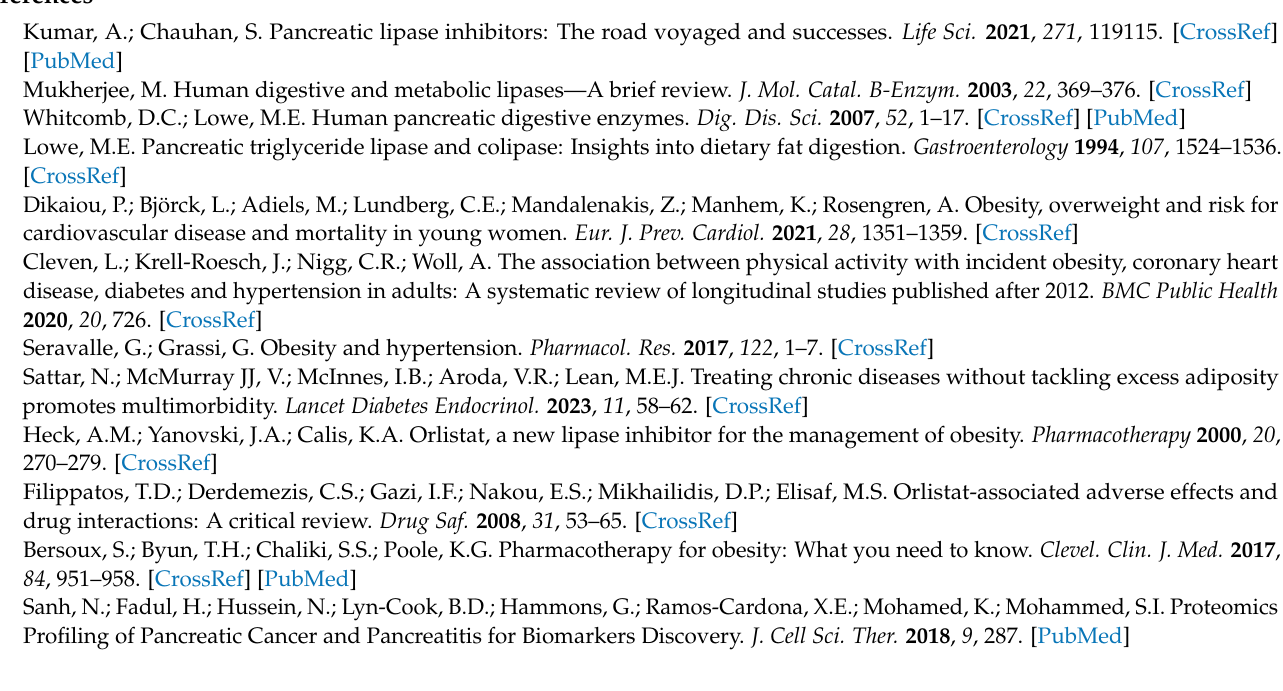
Figure S19: 1 H NMR spectra of compound Resorufin octanoyl ester; Figure S20: 13 C NMR spectra of compound Resorufin octanoyl ester; Figure S21: HRMS spectrum of compound Resorufin octanoyl ester; Figure S22: 1 H NMR spectra of compound Resorufin decanoyl ester; Figure S23: 13 C NMR spectra of compound Resorufin decanoyl ester; Figure S24: HRMS spectrum of compound Resorufin decanoyl ester; Figure S25: 1 H NMR spectra of compound RLE; Figure S26: 13 C NMR spectra of compound RLE; Figure S27: 1 H NMR spectra of compound Resorufin palmitoyl ester; Figure S28: 13 C NMR spectra of compound Resorufin palmitoyl ester; Figure S29: HRMS spectrum of compound Resorufin palmitoyl ester; Figure S30: 1 H NMR spectra of compound Resorufin stearyl esters; Figure S31: 13 C NMR spectra of compound Resorufin stearyl esters; Figure S32: HRMS spectrum of compound Resorufin stearyl esters; Table S1: The reported fluorescent substrates for sensing pancreatic lipase; Table S2: Residual activity of 94 natural products derived from herbs (10 µ M, final concentration) against hPL-catalyzed RLE hydrolysis; Table S3: Residual activity of 94 drugs (10 µ M, final concentration) against hPL-catalyzed RLE